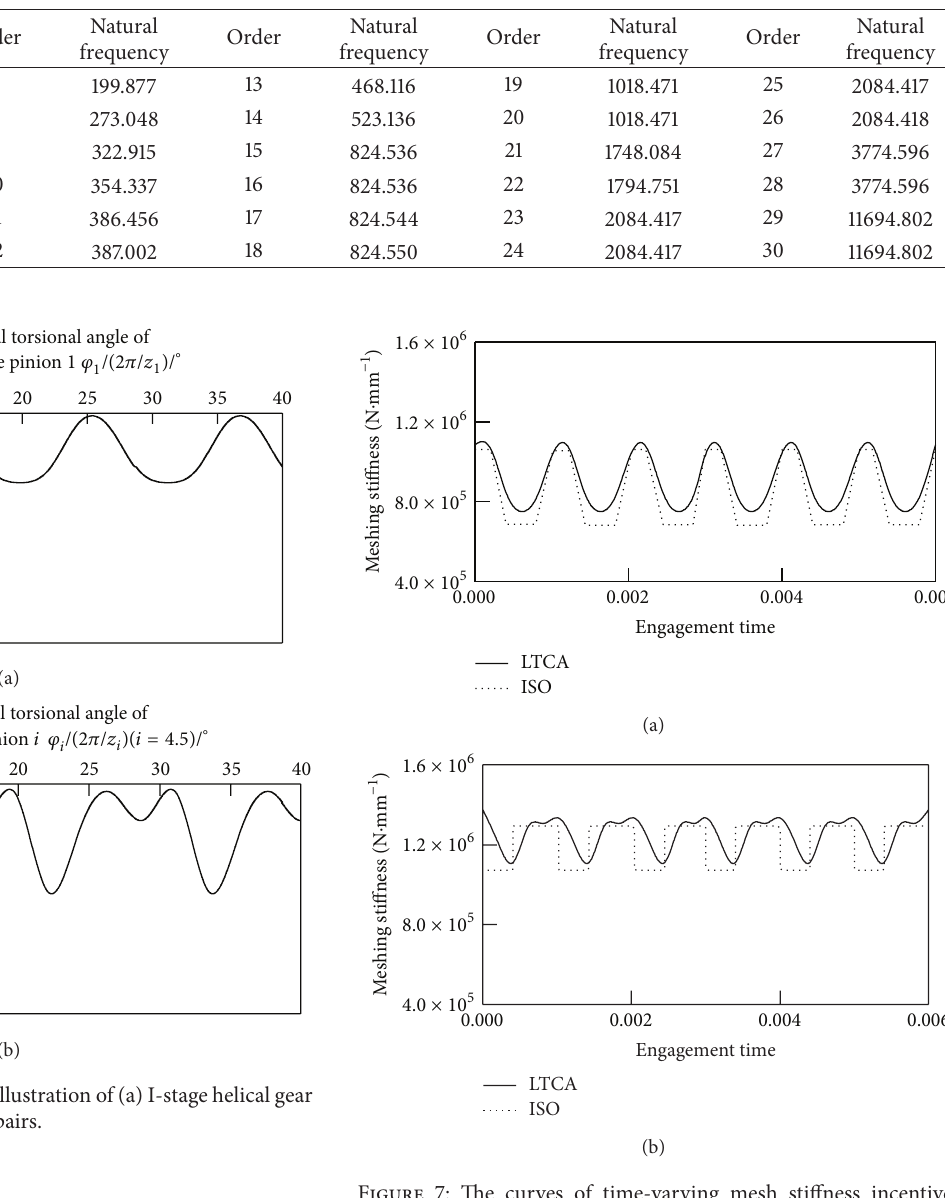
Figure 9 is time-history dynamic load and FFT spectrum diagram of the gears at all levels of